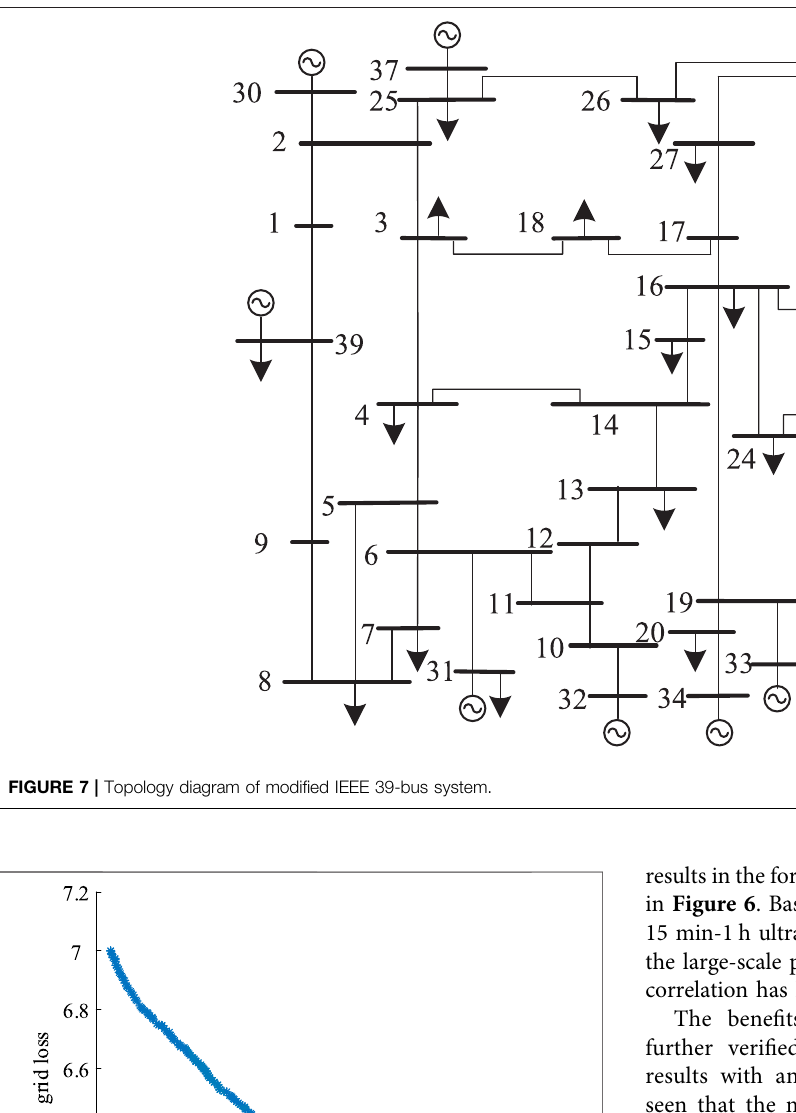
Frontiers in Energy Research |